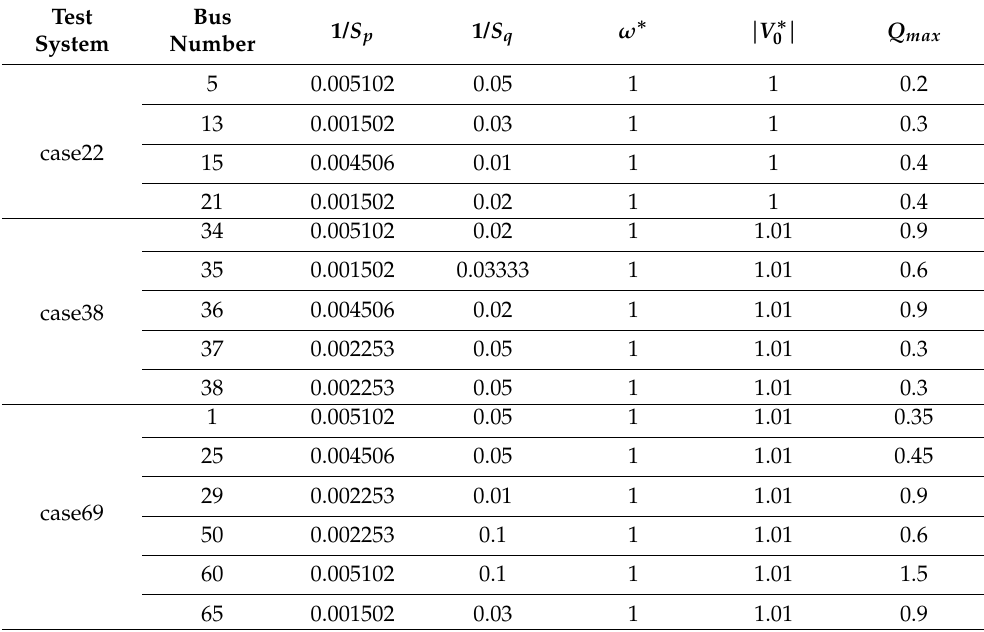
Table 5. Droop gains, nominal values, and operative mode of DGs and Q max limit for the case22, case38, and case69 test systems.